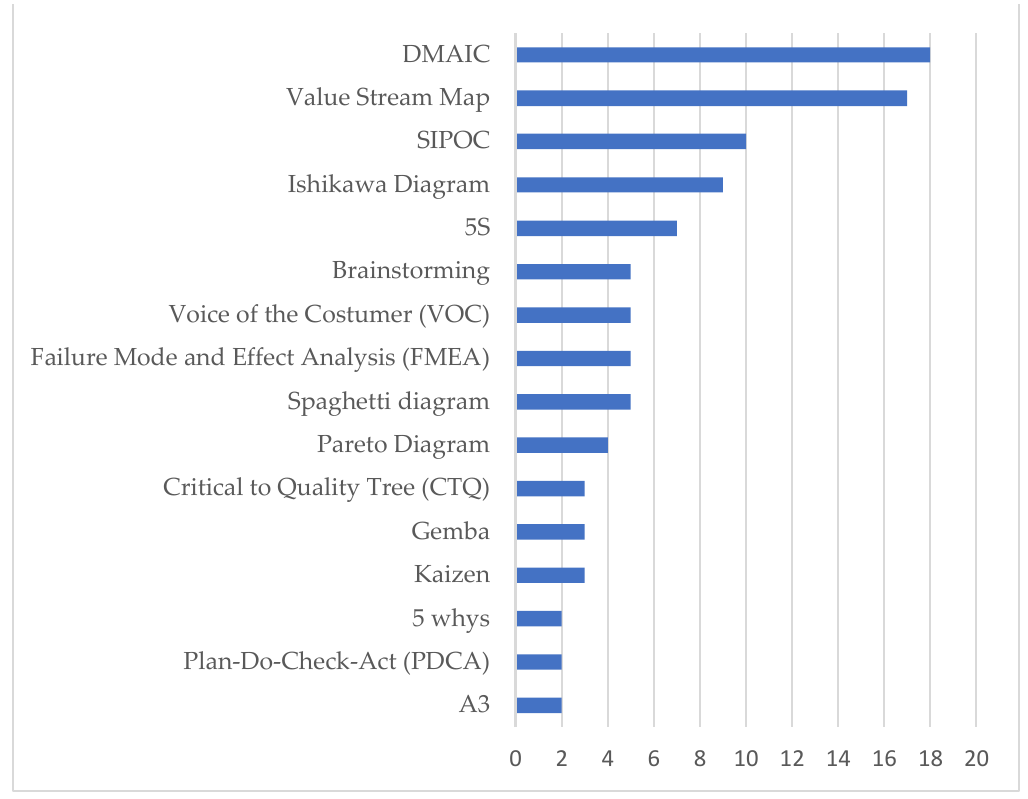
Figure 6. Main tools used by the articles included. With the application of the tools, different results were achieved. Those that appear the most are related to the length of stay and lead times of patients in the units studied. studies in total can be seen.